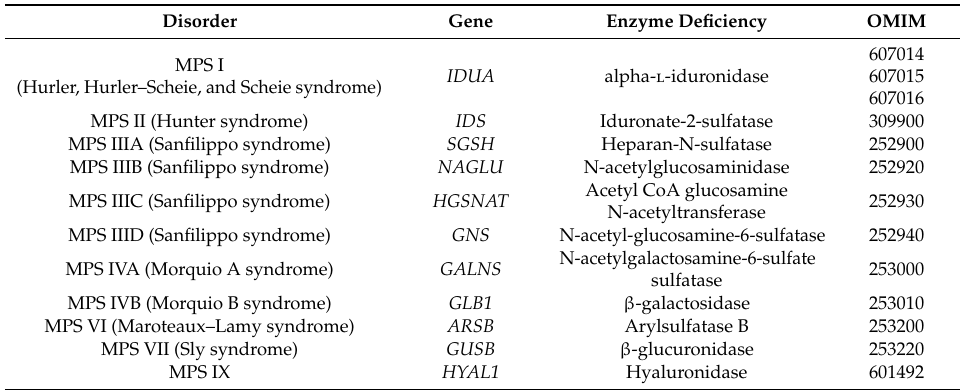
Table 1. Classification of the mucopolysaccharidoses